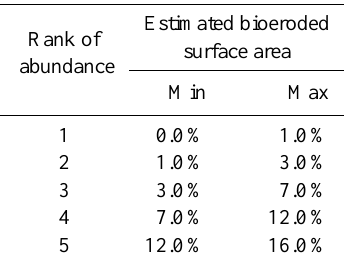
Table 1. Range of percentages of bioeroded surface area attributed to each abundance rank for light microscopy measurements. Data are presented as the minimum and maximum value measured out of 5 measurements per